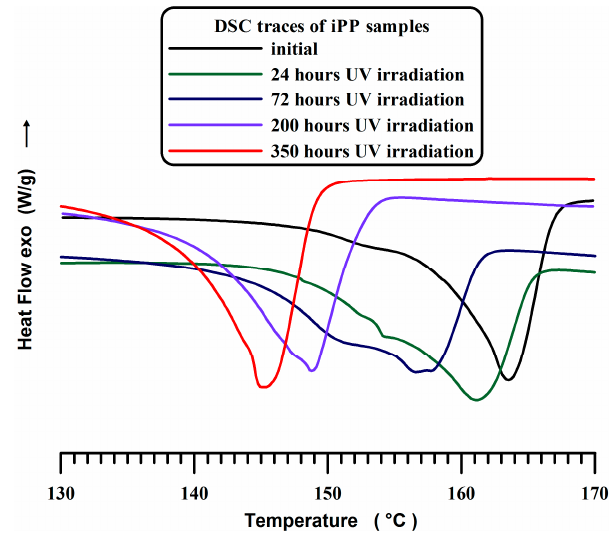
Figure 6. DSC traces of pure iPP (A) sample subject to UV irradiation at increasing times.